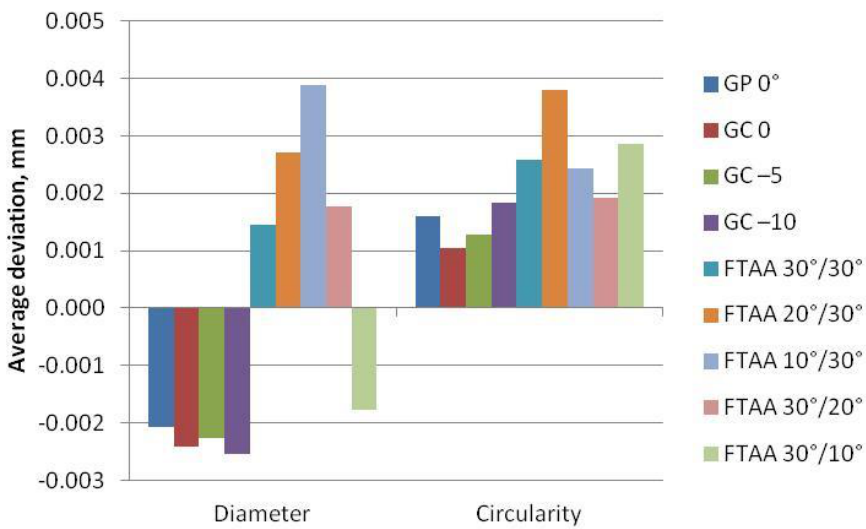
Figure 6. The average deviations for the two chosen tasks, measured on the ring standard using nine different path control algorithms.